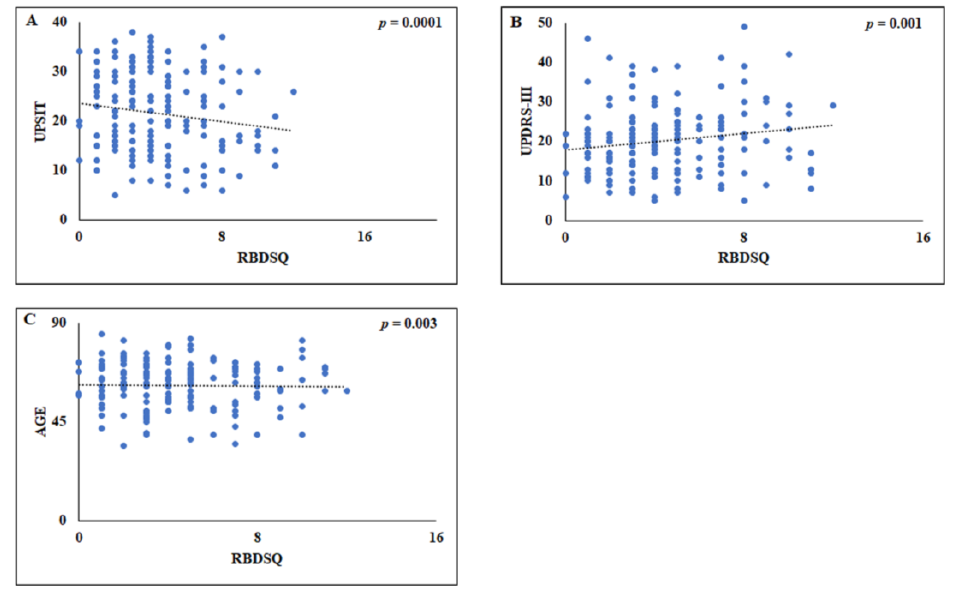
Figure 1. Scatterplots of the relationship between Rapid Eye Movement Sleep Behavior Disorder Screening Questionnaire (RBDSQ) versus University of Pennsylvania Smell Identification Test (UPSIT) ( A ), between RBDSQ versus Unified Parkinson’s disease rating scale part III (UPDRS) ( B ), and between RBDSQ versus age ( C ).